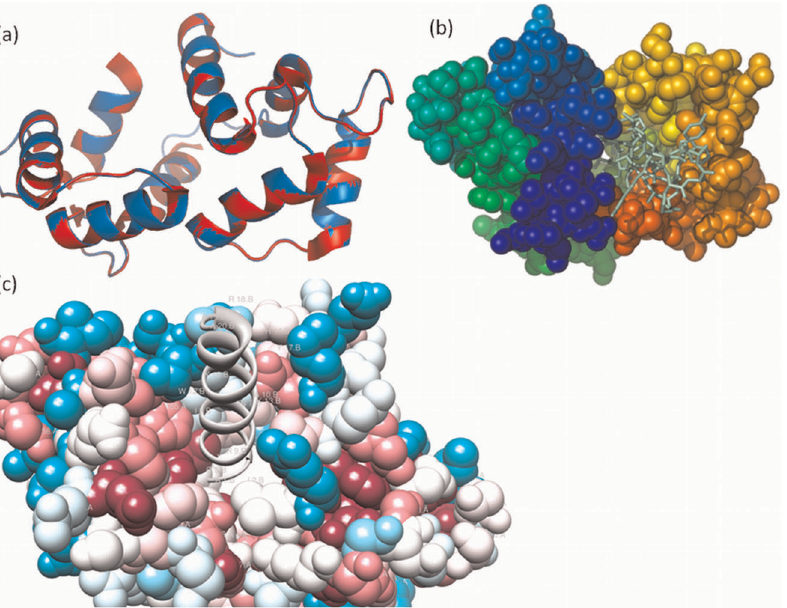
Figure 2. CaM-like modelled protein with its ligand IQ1 motif. (a) Superimposed structures of theoretical 3D model of the CaM-like protein (with C-alpha atoms only) on its respective template in cartoon representation. Template is in blue colour and model is in red colour; (b) CaM-like protein in complex with IQ1 motif. The ligand IQ1 motif is shown as grey stick; (c) Dark violet colour is for the most conserved. The ligand IQ1 motif is shown as grey ribbon.